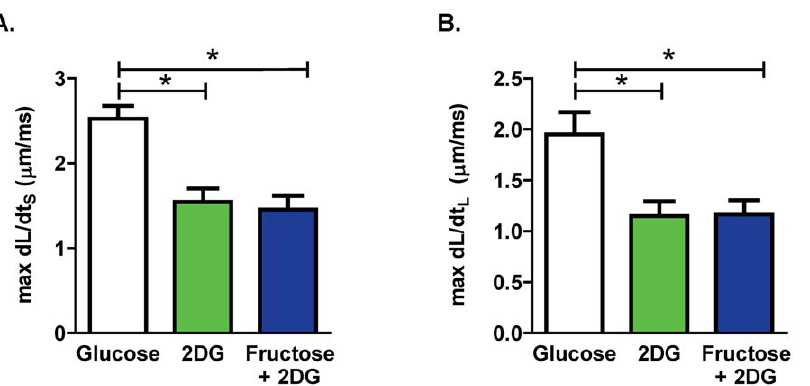
Figure 5. Effect of fructose on cardiomyocyte contractility. A. Maximum rate of cardiomyocyte shortening (max dL/dt S ). B. Maximum rate of cardiomyocyte lengthening (max dL/dt L ). Data presented as mean 6 s.e.m. n=10–28 cells/group. *p , 0.05 (1-way ANOVA, Newman-Keuls post-hoc